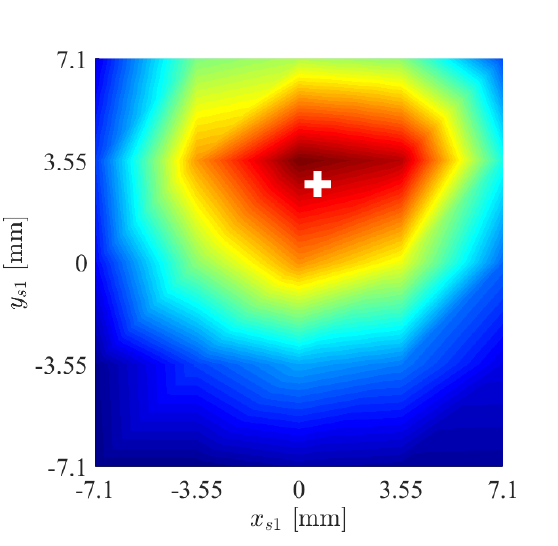
Figure 22. Fourth experiment: Tactile map and corresponding centroid (white